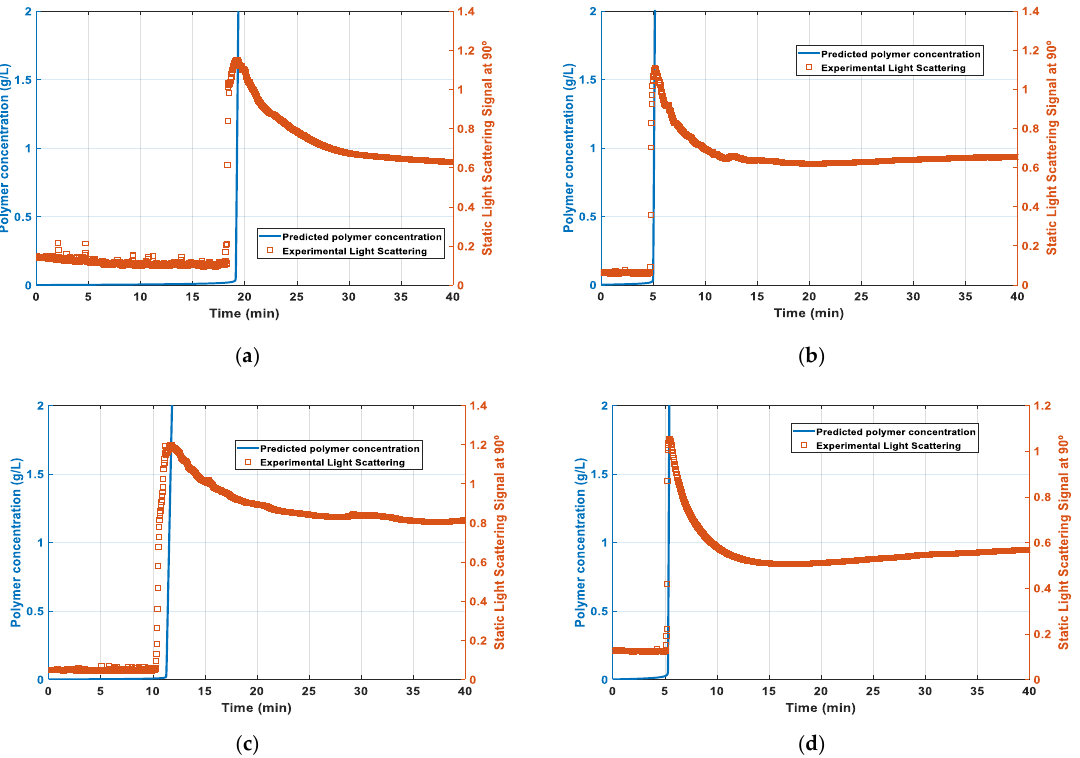
Figure 6. Predicted time-evolution of polymer concentration (g/L) and in-line measured static light scattering signal (the 90° detector is here considered) for polyacrylamide synthesis at different starting conditions. ( a ) homopolymer L1, ( b ) L2, ( c ) L3, and ( d ) L4 (see Table 1).